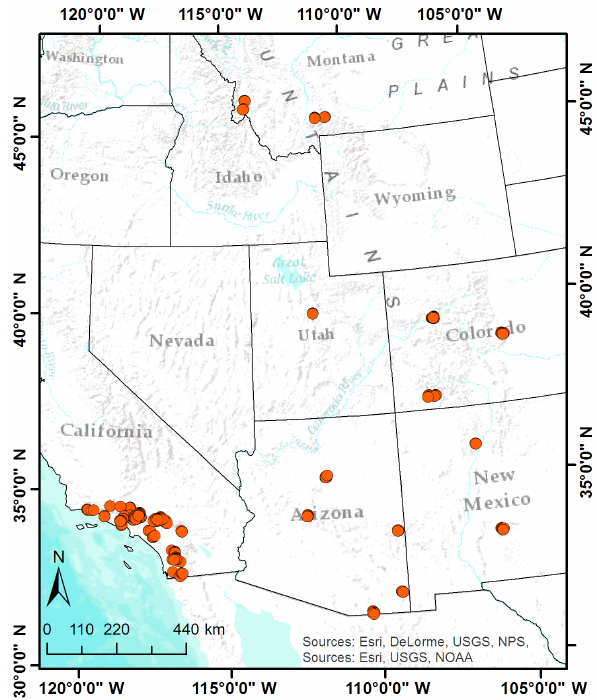
Figure 1. Location of all post-fire debris flow records included in the USGS database. Note that all events in Utah and Montana were excluded from the analysis due to their incomplete record of vari-